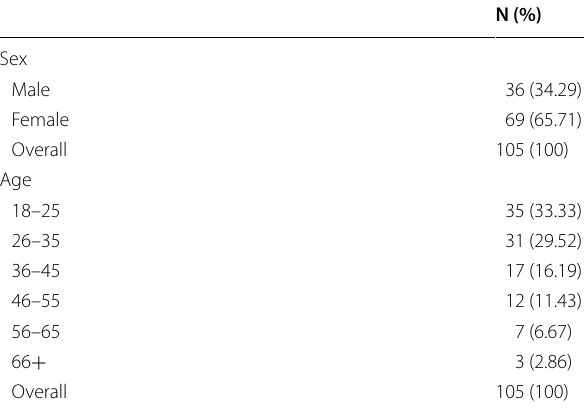
Table 1 Overall relative frequencies of age classes among entire population and prevalence of genders